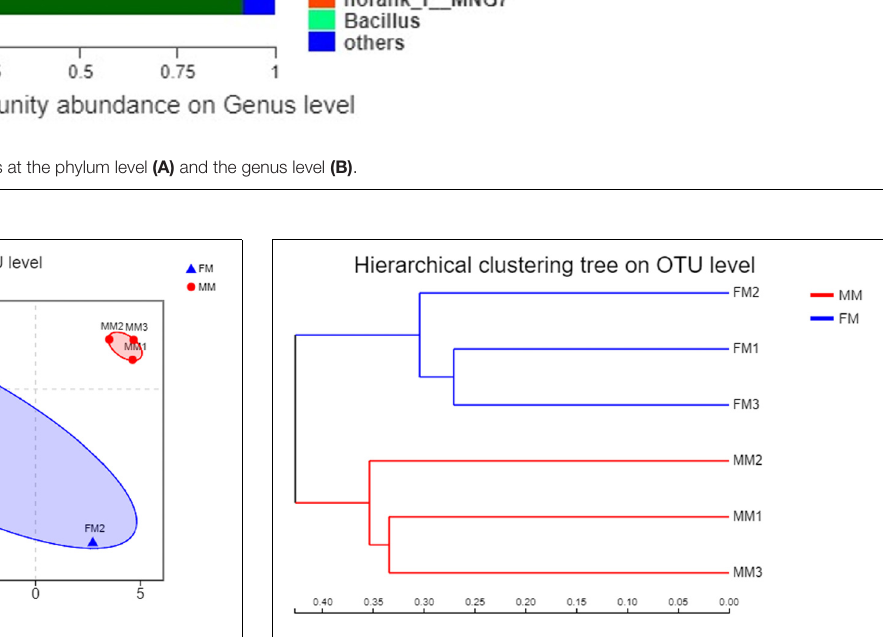
FIGURE 3 | NMDS ordination based on Binary_euclidean similarities of bacterial communities. The blue triangles represent female swamp eels (FM), and the red circles represent male swamp eels (MM).